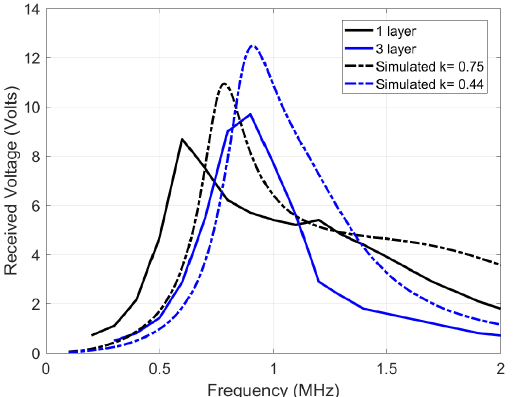
Figure 9. Channel response of the 12 µ H transmit and receive coils, tuned individually to 1 MHz using 2.2 nF